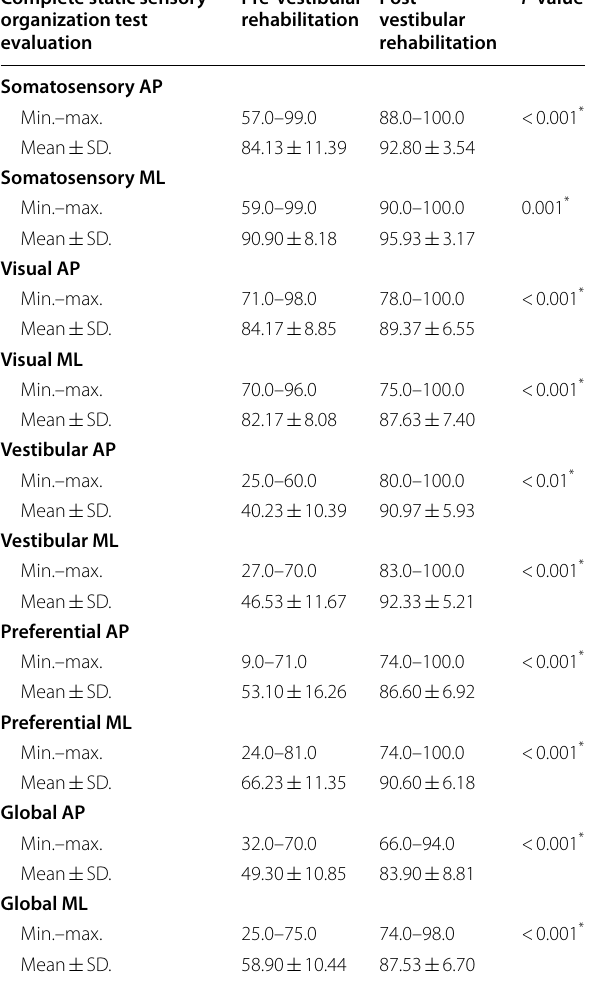
Table 4 Comparison between static SOT results before and after